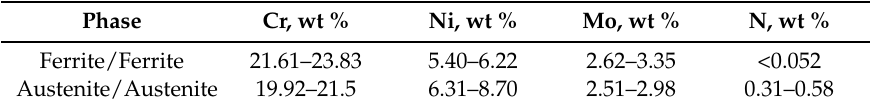
Table 2. Variation of the alloying elements concentration from the weld, for a linear energy, E l = 15 kJ/cm.